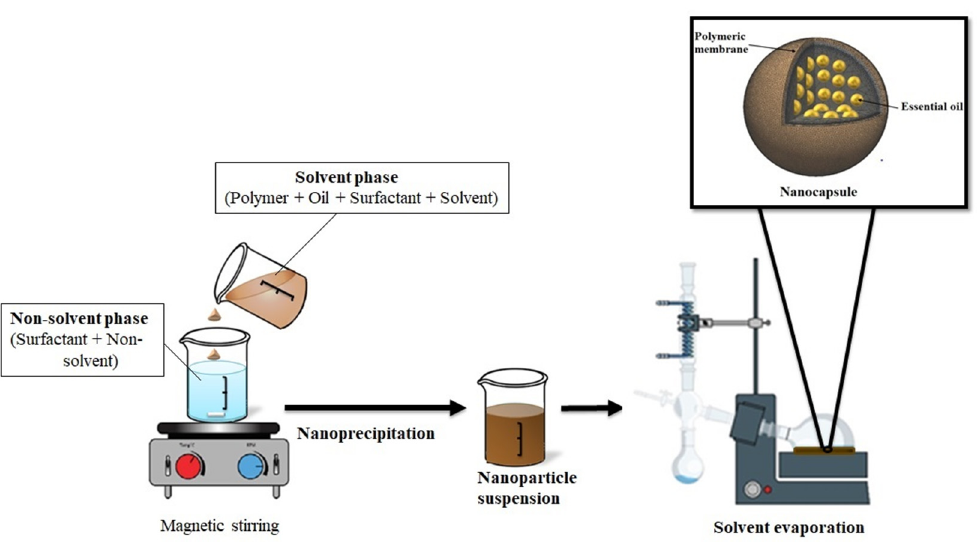
Figure 3. Nanoprecipitation Method.